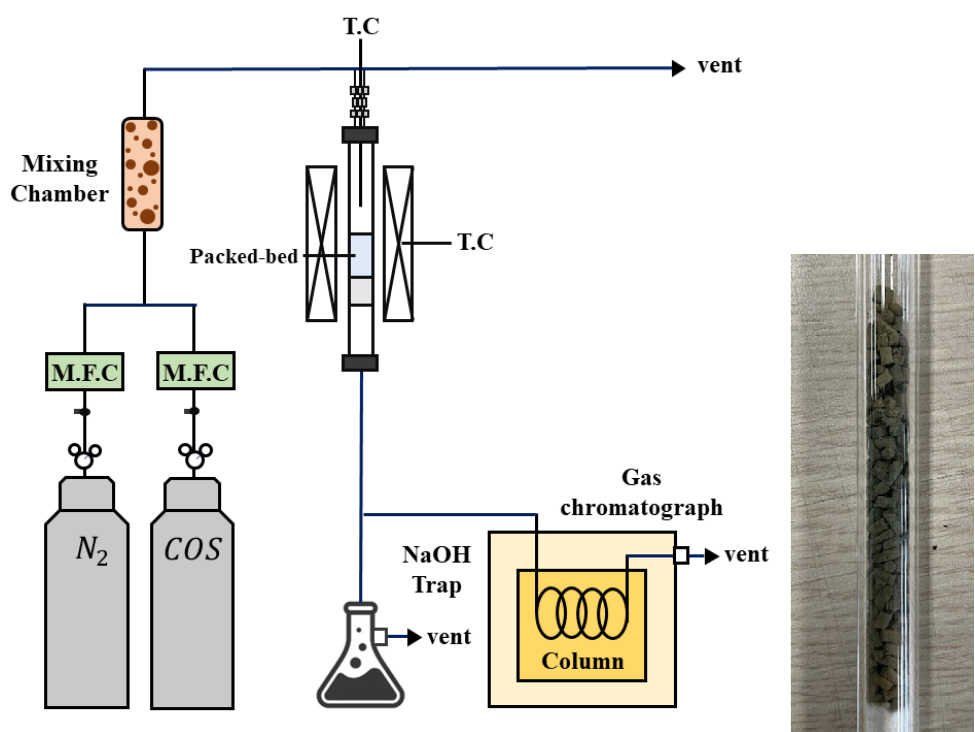
Figure 4. Schematic diagram of the experimental setup for the desulfurization tests.